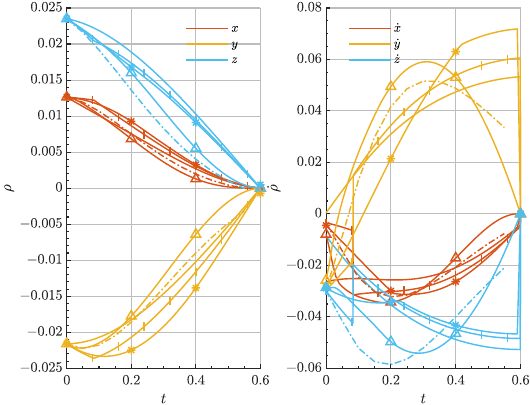
Figure 4. Relative state evolution for the TI (solid), AL-iLQR (dashed), Opt-MI (*), MI (barred), MISG (triangled) strategies.